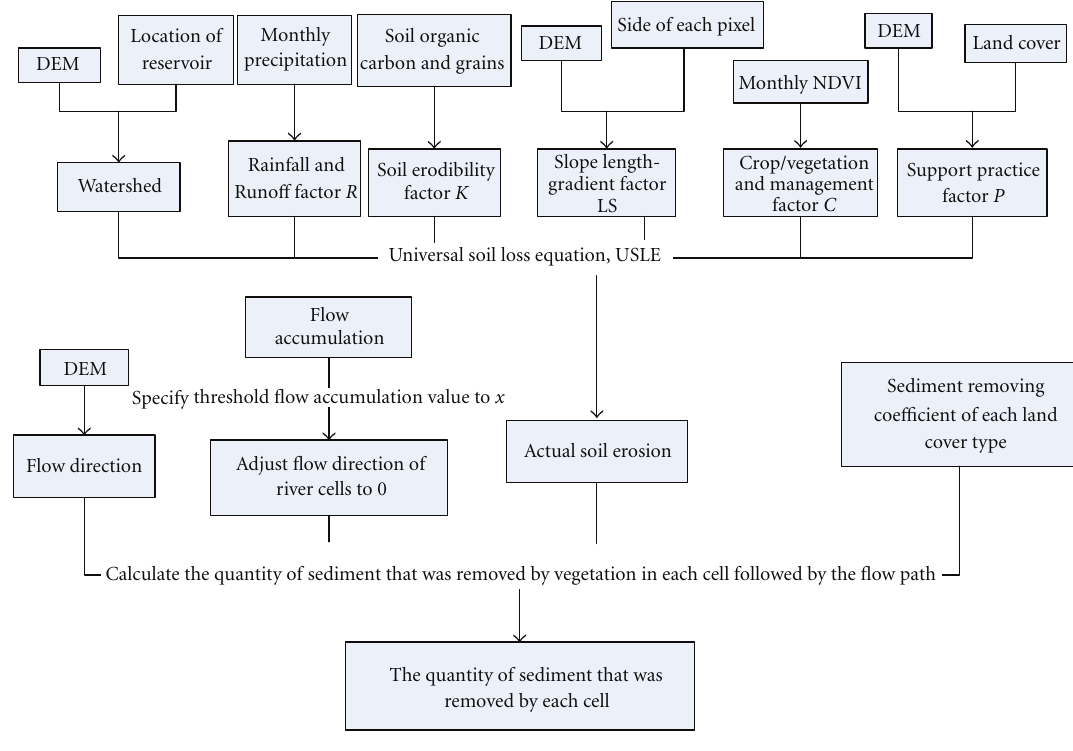
Figure 2: The flow chart of mapping biophysical